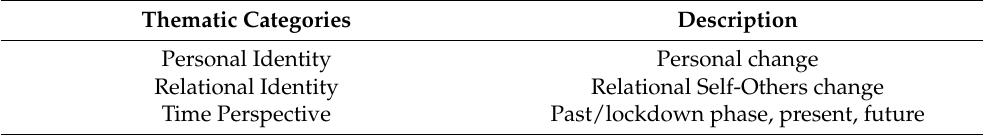
Table 1. Categorical content analysis with a top down approach. Thematic